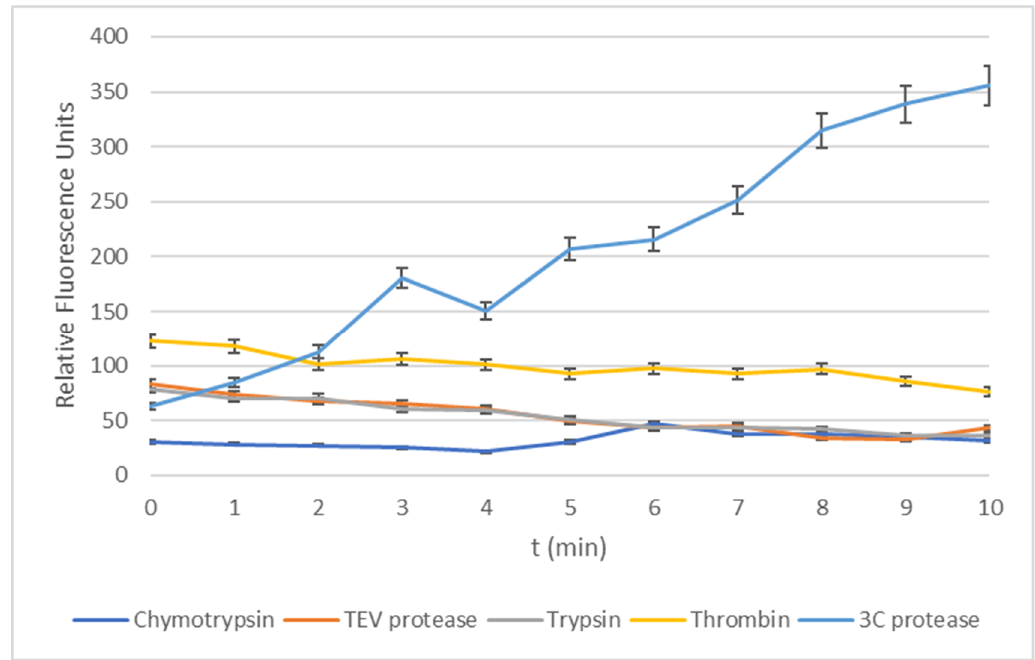
Figure 2. Graph of normalised data between 0–400 to show comparison of all enzymes tested with substrate 2 with 3C pro . Concentrations for enzymes between 13.8 µM–15 µM and substrate 100 µM. Errors bars show 5% deviation.